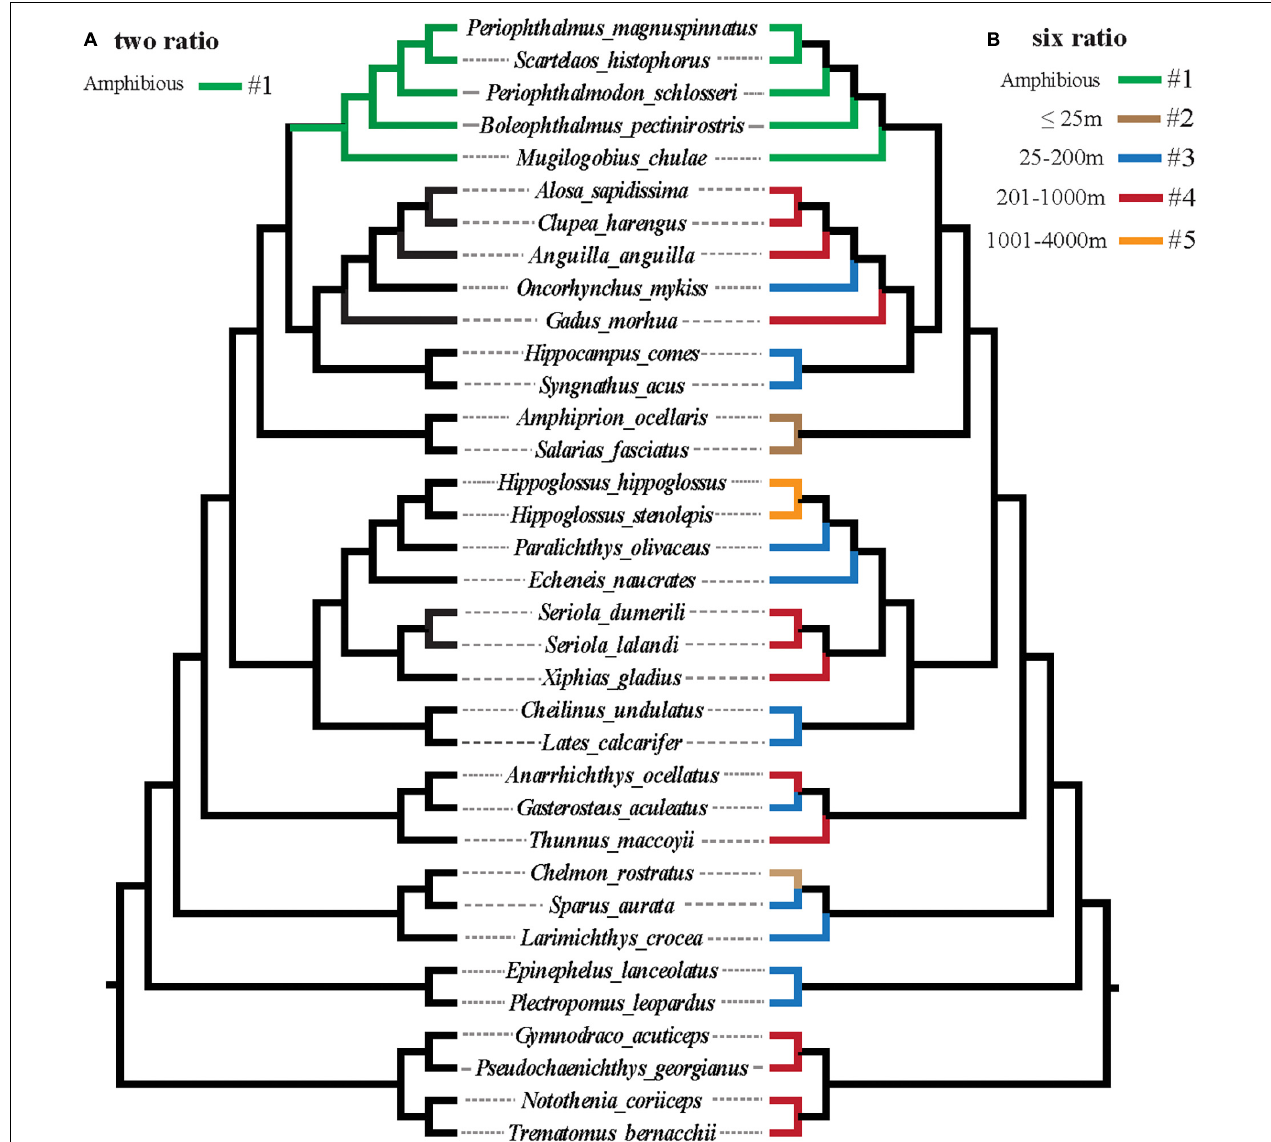
FIGURE 2 | (A,B) Graphical representation of branch models implemented to test for a possible role of selection across different teleost lineages with different diving